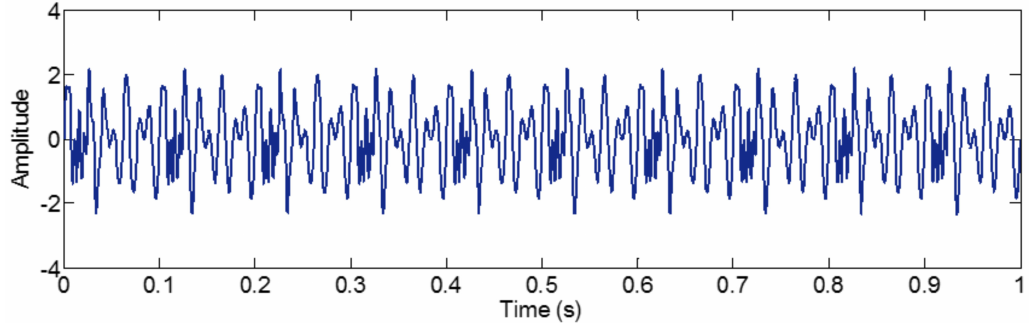
Figure 30. The waveform of the sample signal f sig 7